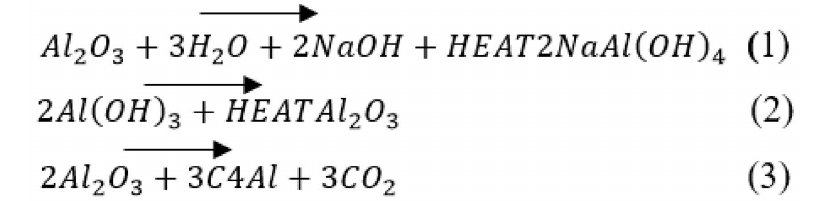
Figure 6. The Bayer process